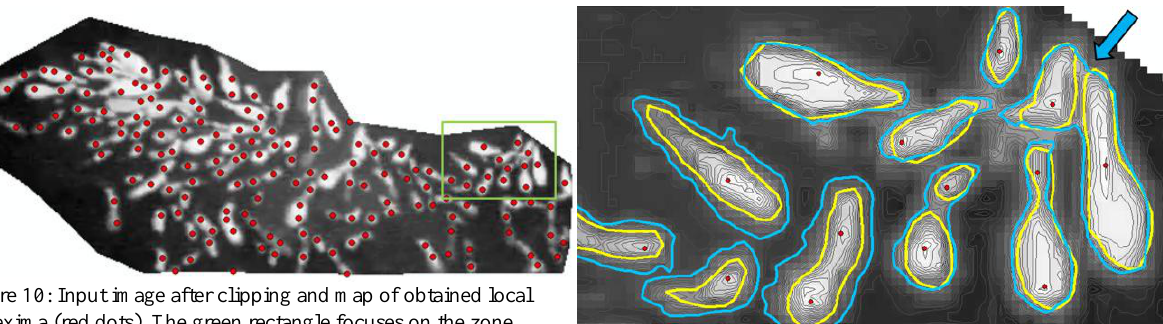
Figure 10: Input image after clipping and map of obtained local maxima (red dots). The green rectangle focuses on the zone represented in Figures 11 and 12. Figure 12: Manually digitized polygons (yellow) and polygons generated and selected by the algorithm (blue) with their corresponding local maxima (red). The blue arrow indicates an error of the automatic procedure, joining two close hippos as a single one. The total number of animals detected by the algorithm varies between 74 and 108 (Table 2). It shows a good agreement with reference values derived from manual counting: the error is ranging from -9.8% to +13.7%, with a mean value of +2.3%, which is not significantly different from 0 (p = 0.67). The